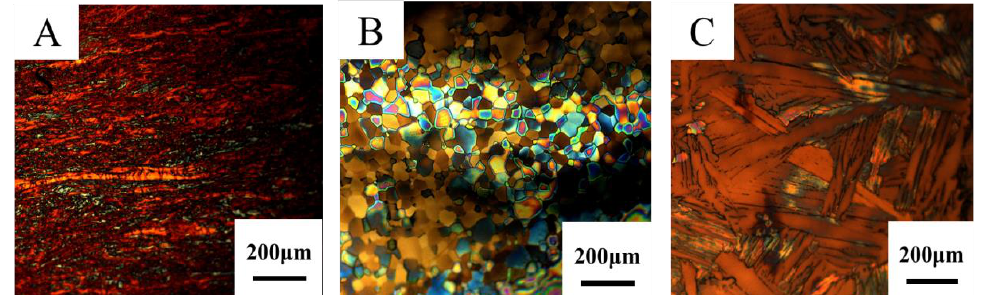
Figure 8. Microstructure of high-purity Ti targets at different annealing temperatures. ( A ) Target C1; ( B ) Target C; ( C ) Target C2.